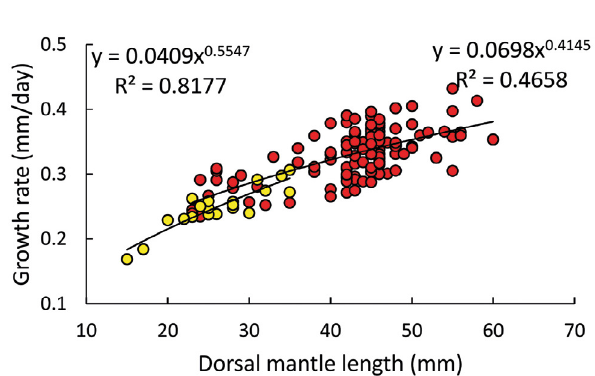
Fig. 5. – Relationship between dorsal mantle length and growth rate of males (yellow circles) and females (red circles) Abralia andamanica from the Arabian